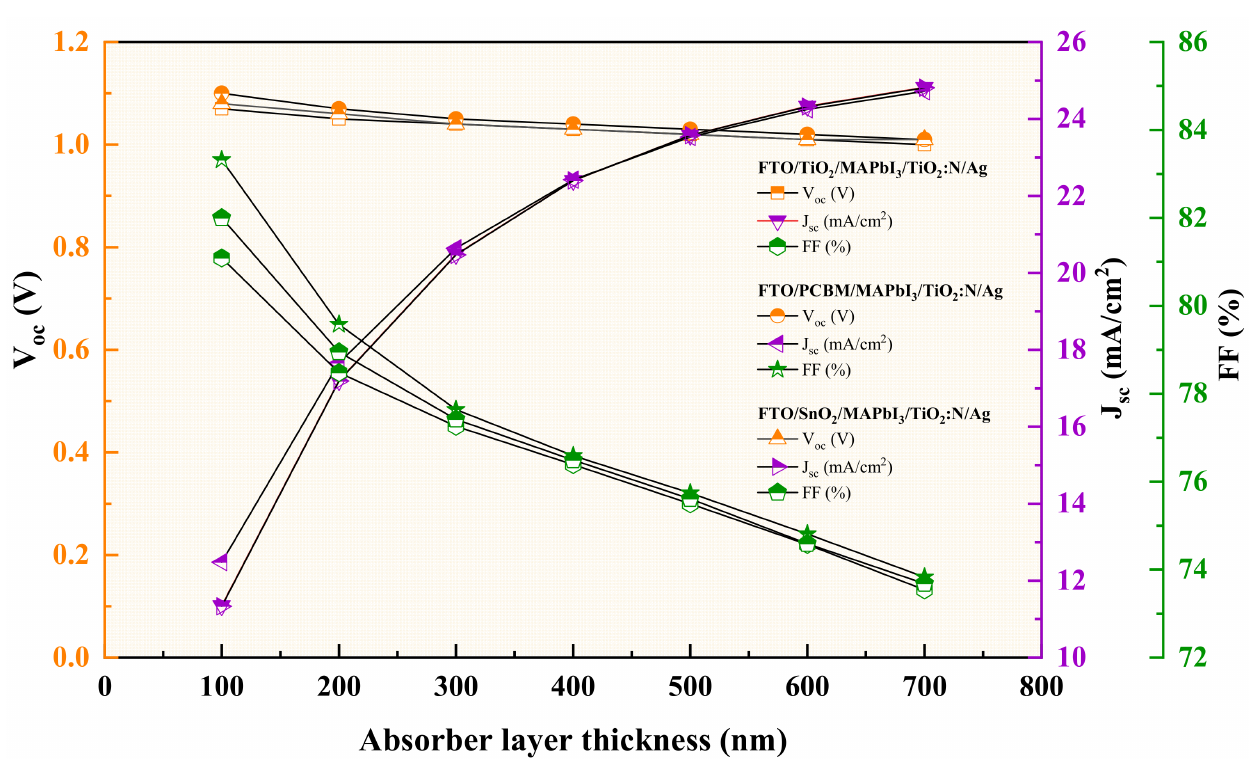
Figure 4. Patterns of the performance parameters for different absorber layer